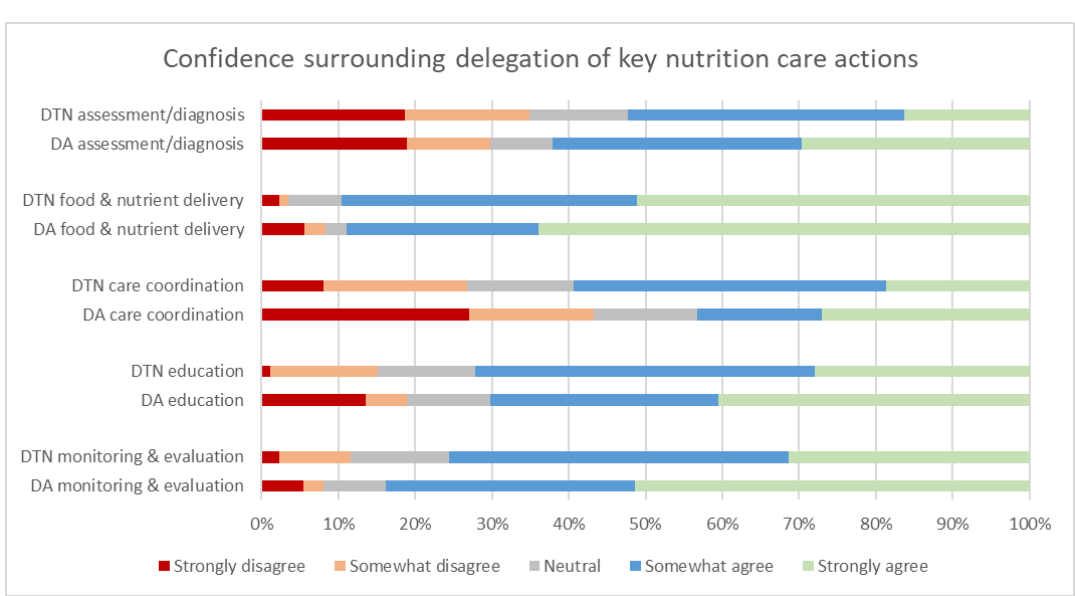
Figure 2. Confidence of dietitians (DTN) ( n = 86) * and dietitian assistants (DA) ( n = 36) * surrounding delegation of key nutrition care actions. * An additional 1 dietitian assistant completed 4 of the 5 question sub-components.